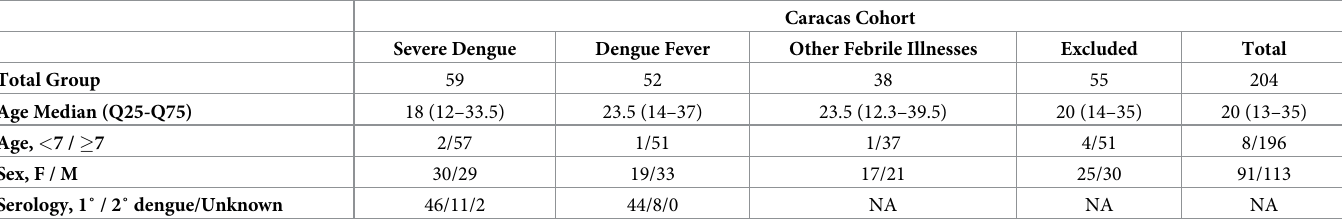
Table 1. Description of the study